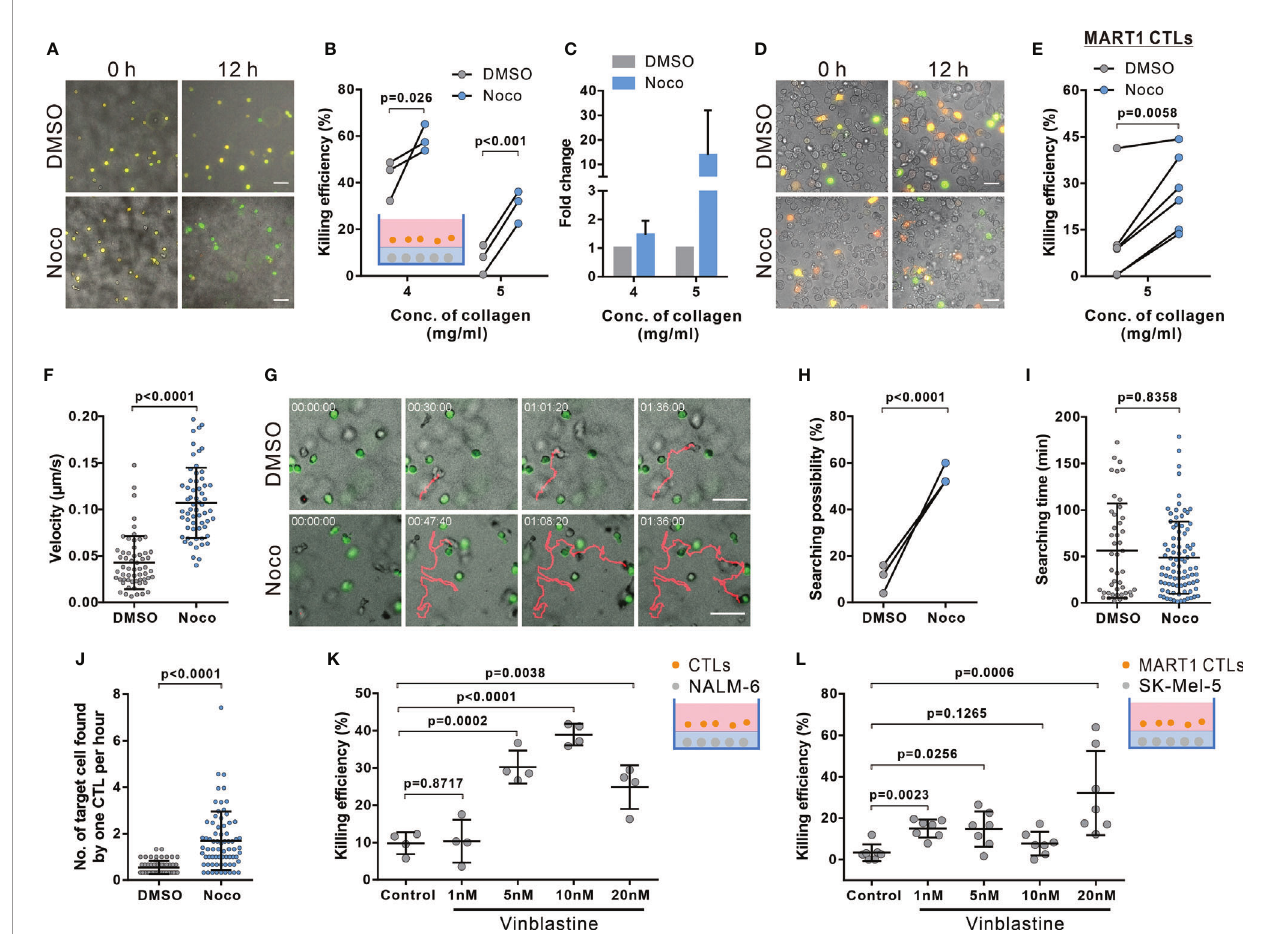
FIGURE 5 | Disruption of microtubules ameliorates impaired CTL killing in dense collagen matrices. (A – E) Inhibition of microtubule polymerization improves CTL killing in dense collagen. Nocodazole (Noco, 10 µM) was used to disrupt the microtubule network. Images were acquired using ImageXpress (20× objective) at 0 and 12 hours. NALM-6-pCasper and bead-stimulated CTLs (A – C) , or SK-Mel-5 pCasper and MART1-speci fi c CTLs (D , E) were used as target and killer cells. Representative experiments from 5 mg/ml are shown in (A, D) . (F – J) Nocodazole treatment elevates migration and searching ef fi ciency in dense collagen. CTLs and calcein-loaded target cells (green) were embedded in planer collagen matrix (5 mg/ml) and visualized with cell observer. Migration velocity within the duration of 30 min before conjugating with target cells is shown in (F) . Representative migration trajectories are shown in (G) . The likelihood for CTLs to fi nd target cells and the time required for CTL to fi nd their fi rst target cell are shown in (H, I) . Number of target cells found by one CTL per hour is shown in (J) . (K , L) Vinblastin enhances killing ef fi ciency of CTLs in dense matrices. Respective target cells as indicated were embedded in collagen (5 mg/ml). Killing ef fi ciency was determined at 24 hours (K) or 12h (L) after adding CTLs using ImageXpress (20× objective). The ratio between effector cells and targets is 5:1 in (A – C, K) . The ratio between effector cells and targets is 1:1 in (D , E , L) . One dot represents one donor ( B , H , K , n = 3 donors), one independent experiment ( E , n = 6 and L , n = 7 experiments), or one cell ( F , I , J , n = 4 donors). Scale bars are 50 µm. Results are presented as Mean ± SD. Scale bars are 50 µm. For statistical signi fi cance, the paired Student ’ s t-test (B , E , H) or the Mann-Whitney test (F , I – L) were